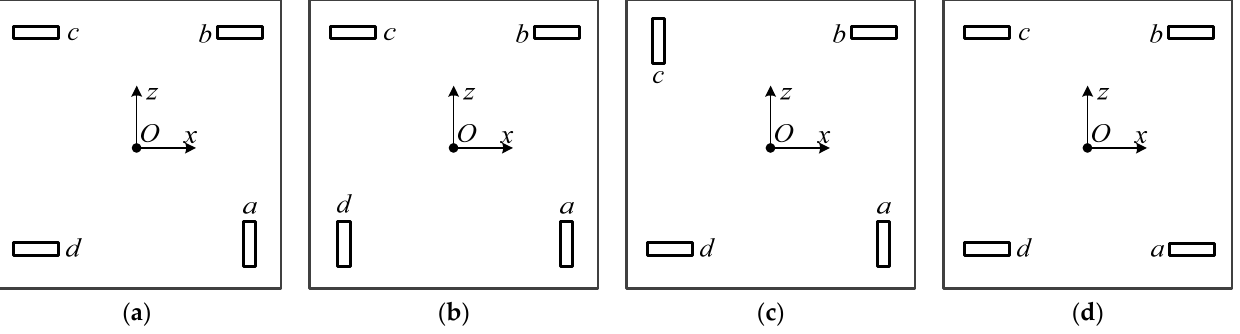
Figure 21. Simplified classification layout of the positioning axis. ( a ) Three-one orthogonal layout; ( b ) two-two diagonal orthogonal layout; ( c ) two-two unilateral orthogonal layout; ( d ) parallel layout. The movement direction of the capture hook is perpendicular to the axial direction of the positioning shaft. When the positioning shaft is arranged in a certain direction, the direction of the contact torque M o ( i ) for each group of hook frames is determined by the movement direction of the capture hook. If the contact force F i for each group of hook frames is equal during capture, the contact torque for each group of hook frames is M o ( i ) = F i · l /2, and the magnitude of the torque has nothing to do with the arrangement direction of the positioning shafts or the movement direction of the capture hook. Thus, the movement direction of the capture hooks can also be simplified into K d (cid:48) = 4 layouts, as shown in Figure 22.